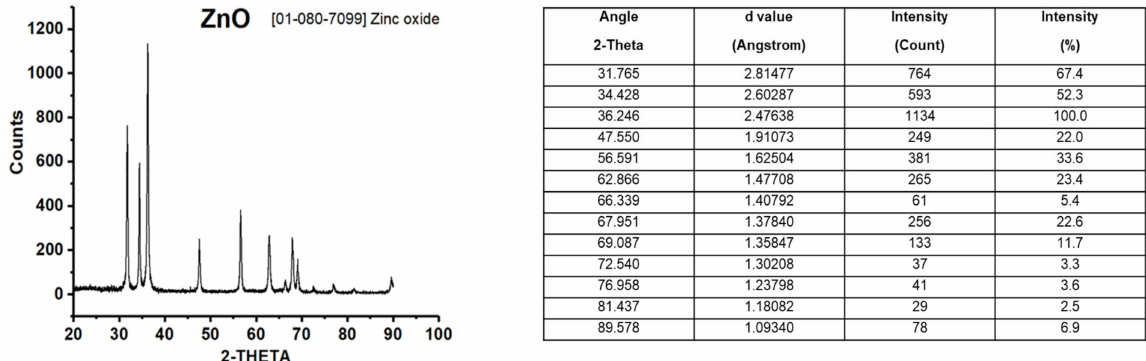
Figure 1. XRD pattern of ZnO NPs. NPs were analyzed in a diffractometer using Cu K α radiation ( λ = 1.541874 Angstrom) in the range of 20–90 ◦ in 2-Theta at a scanning step of 0.020 ◦ /1.2 s. The ZnO: JCPDS card [01-080-7099] is shown on the right side.